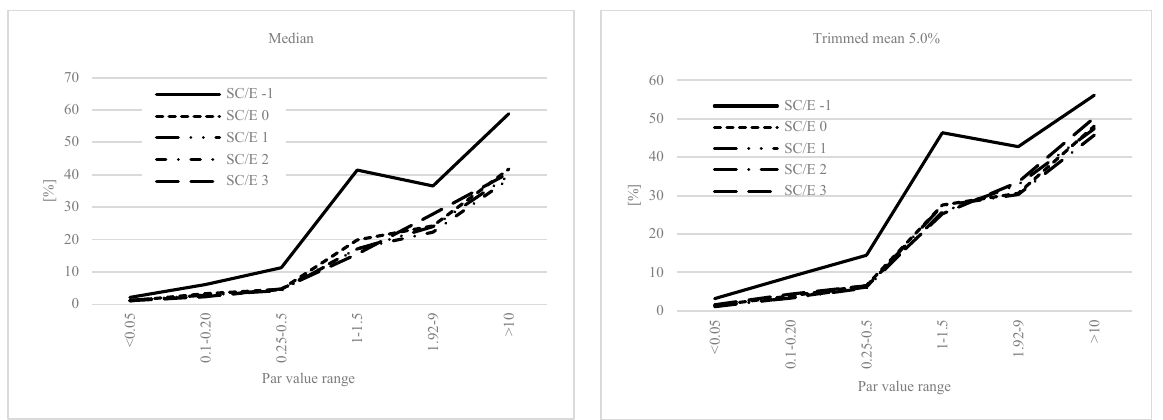
Figure 5. Share-capital-to-equity ratio in subsequent years of issue depending on PaV.